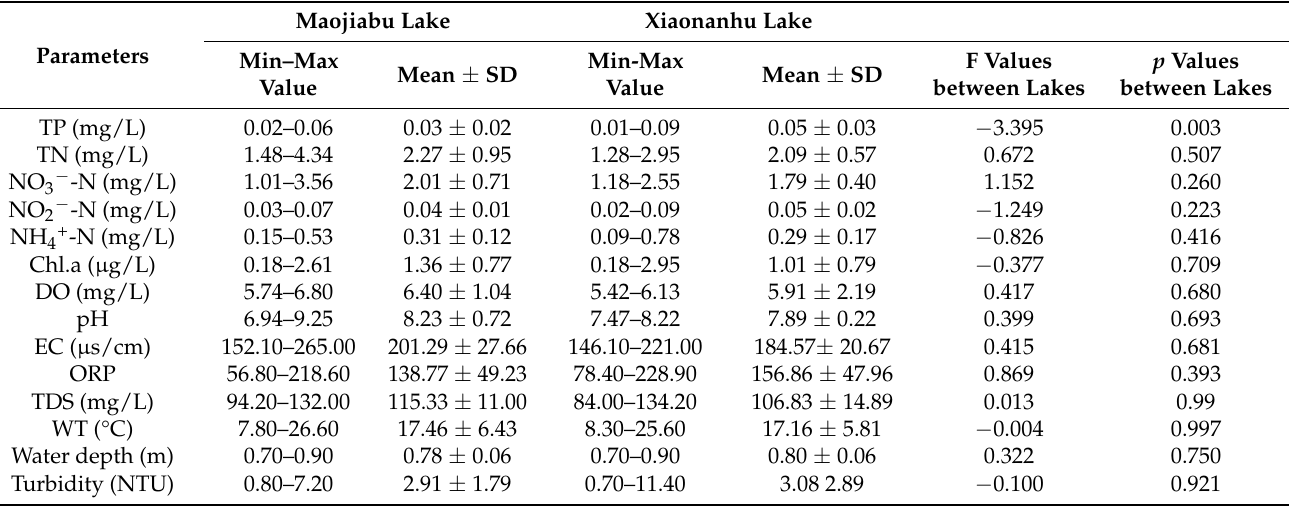
Table 1. Mean ( ± standard deviation), minimum, and maximum values of environment parameters at Maojiabu Lake and Xiaonanhu Lake, and T test